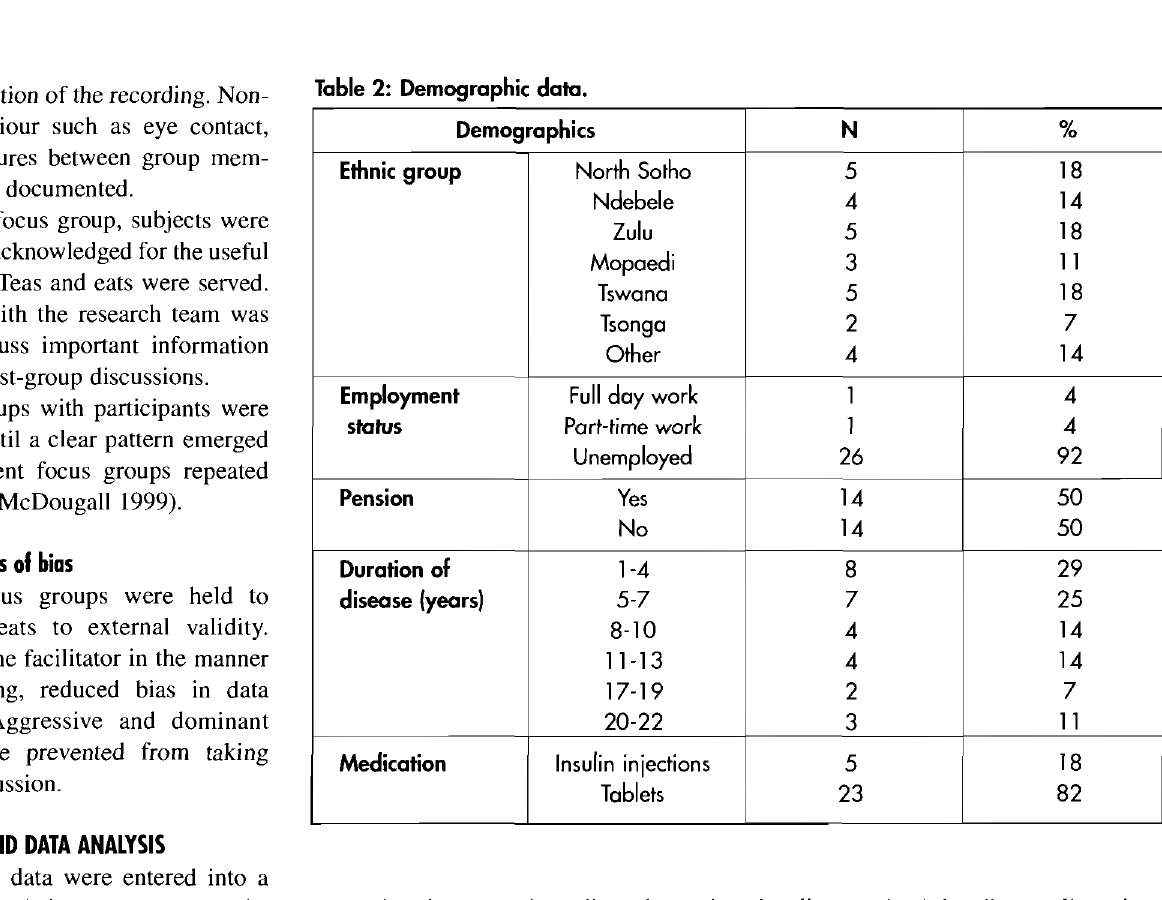
Table 2: Demographic